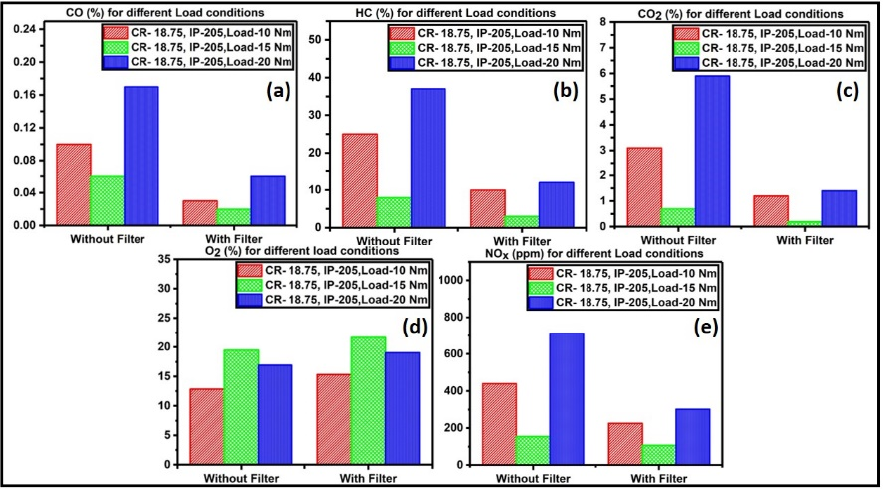
Figure 10. ( a ) CO emission, ( b ) HC emission, ( c ) CO 2 emission, ( d ) NO x emission, and ( e ) O 2 emission recorded when CR = 18.75; IP = 205 bar; load = 10, 15, and 20 Nm.